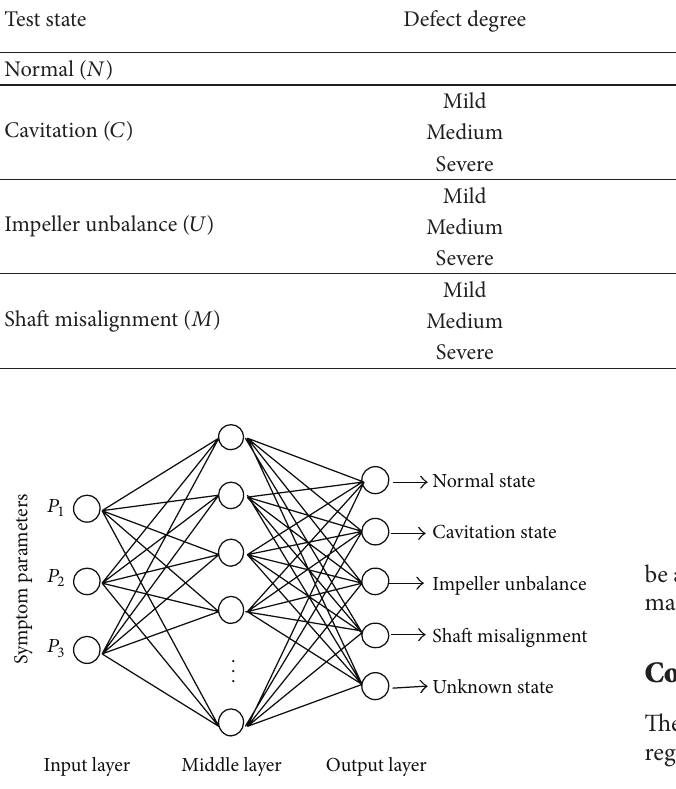
Figure 14: Direct diagnosis method based on fuzzy neural network.